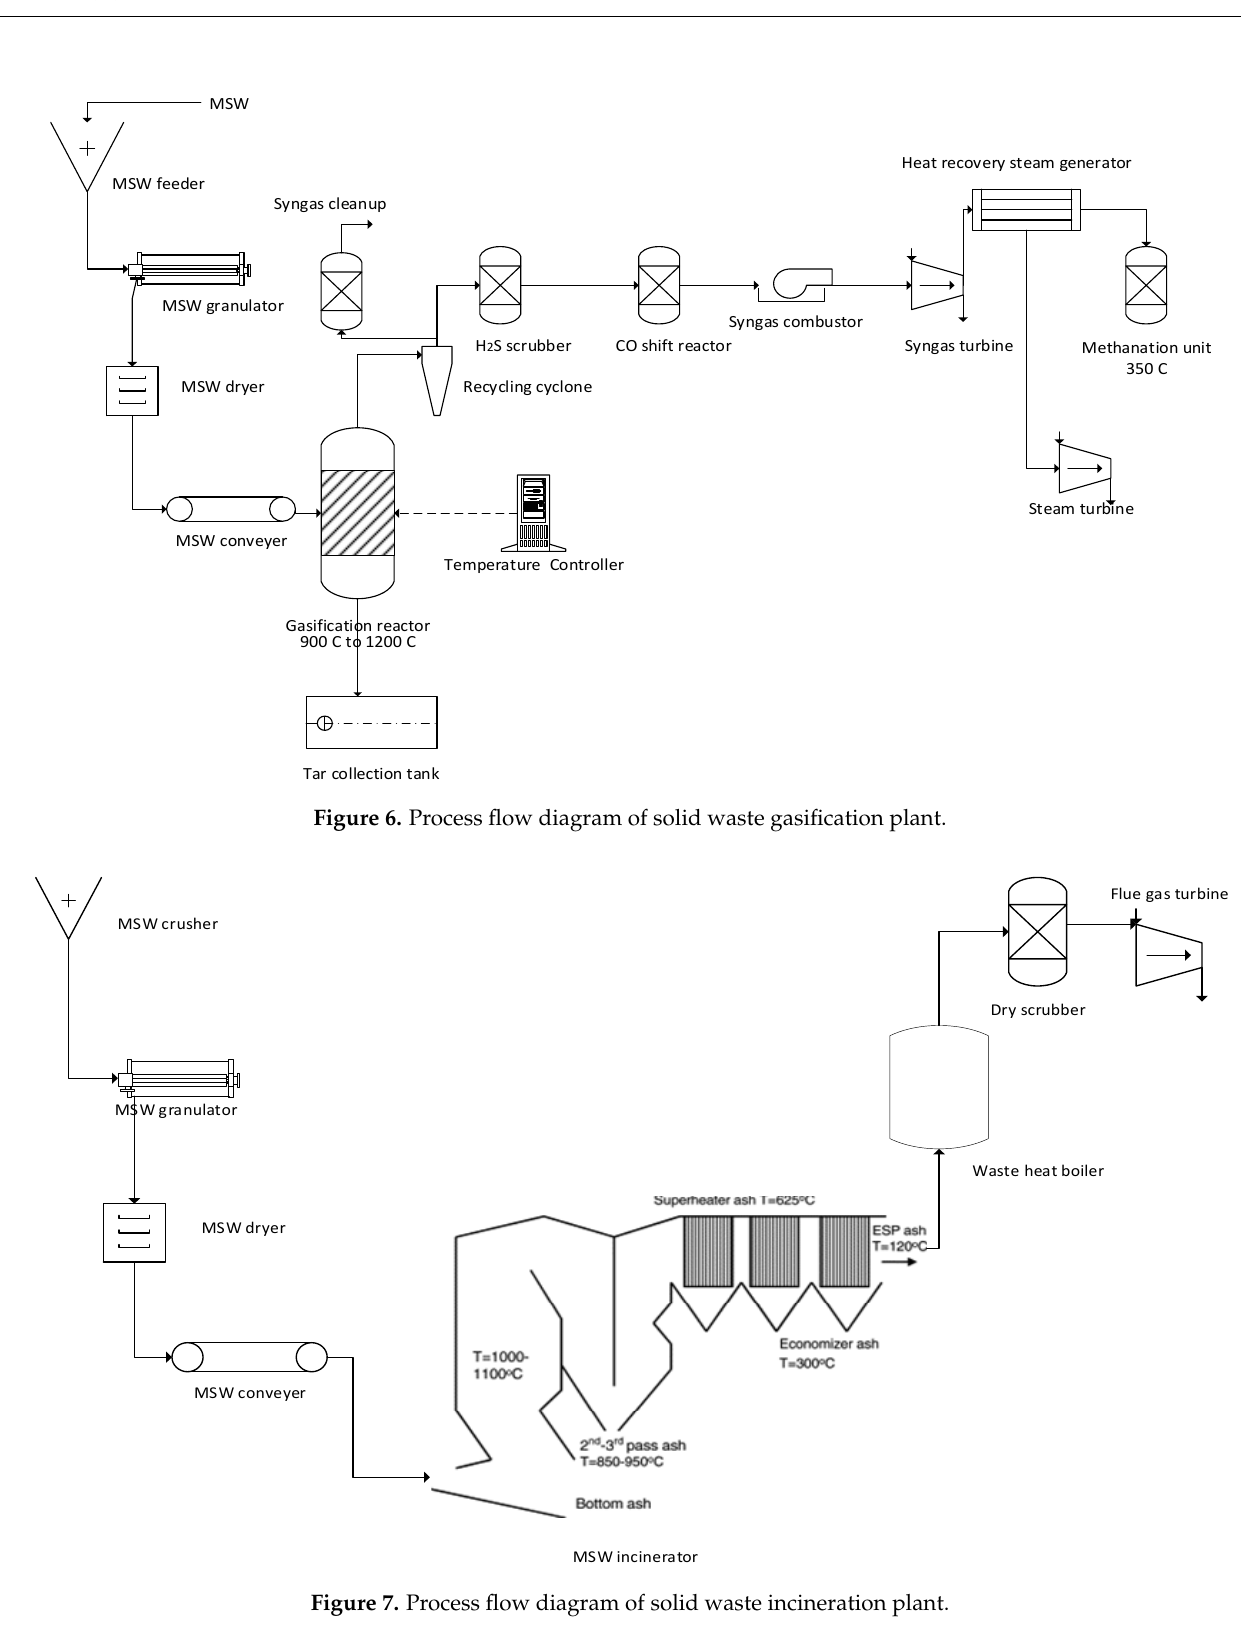
Figure 7. Process flow diagram of solid waste incineration plant.